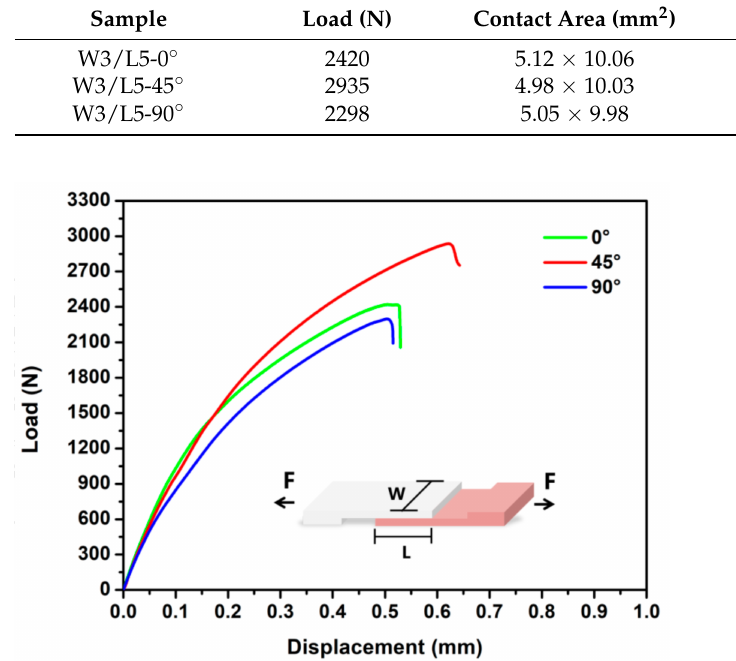
Table 2. Interface shear strength values of W3/L5 laminated composite along 0 ◦ , 45 ◦ and 90 ◦ at RT. Sample